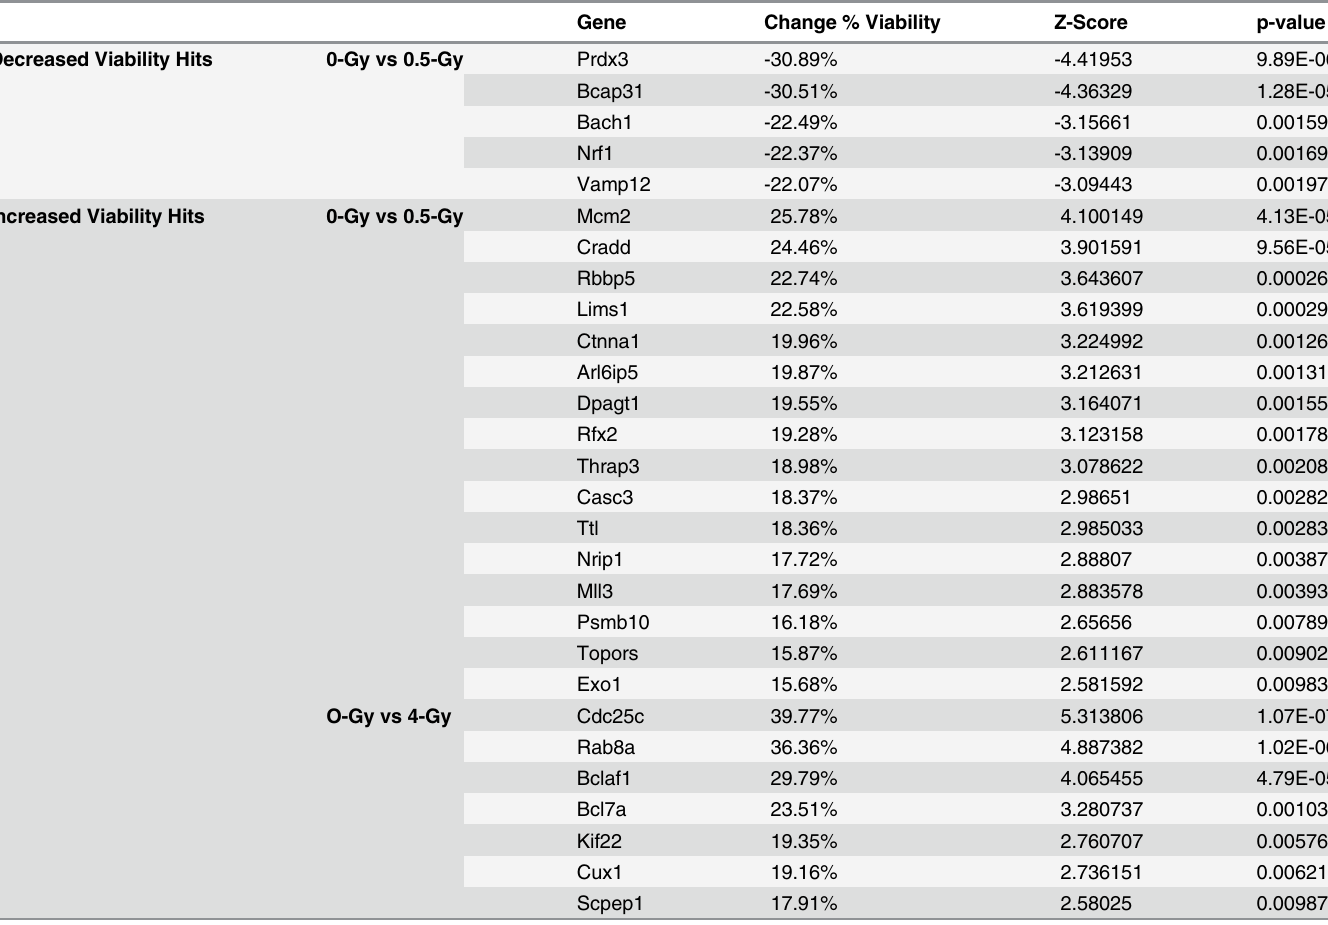
Table 1. Genes associated with significant changes in